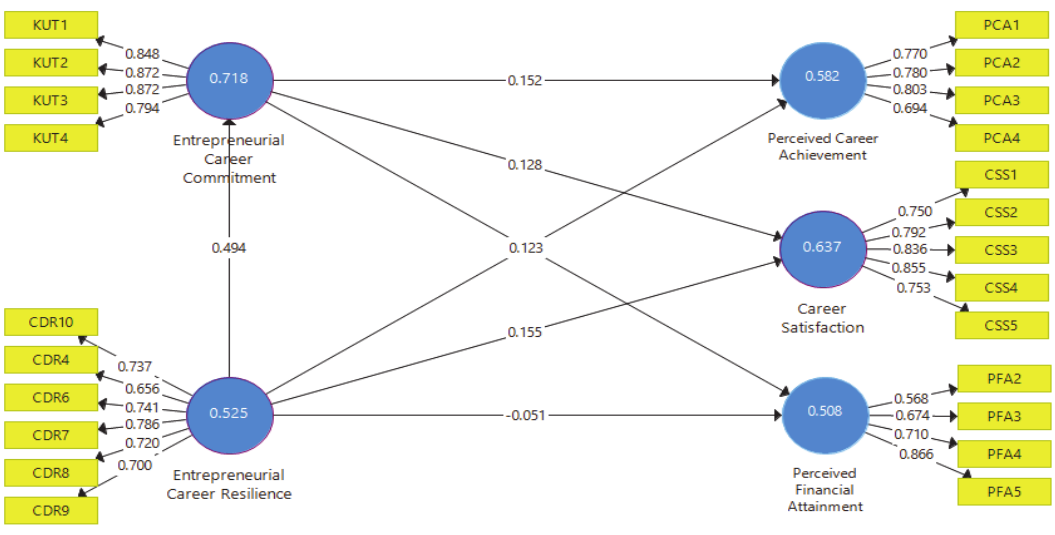
Fig. 2. Measurement